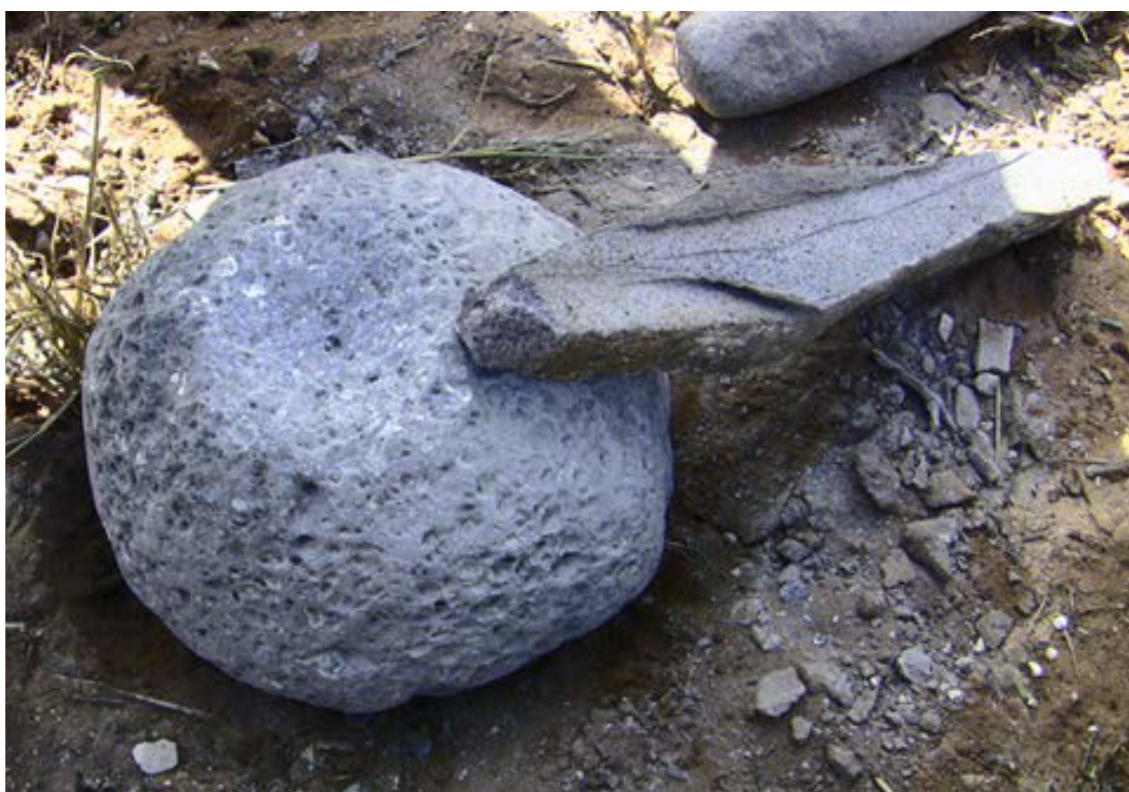
Figure 4. The second working tool with its wide sharp tip.